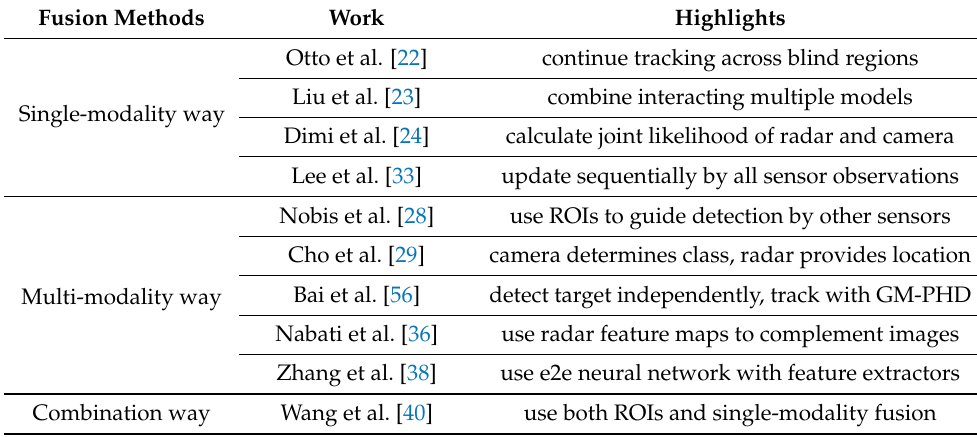
Table 1. Summary of some tracking methods by sensor fusion with radar and